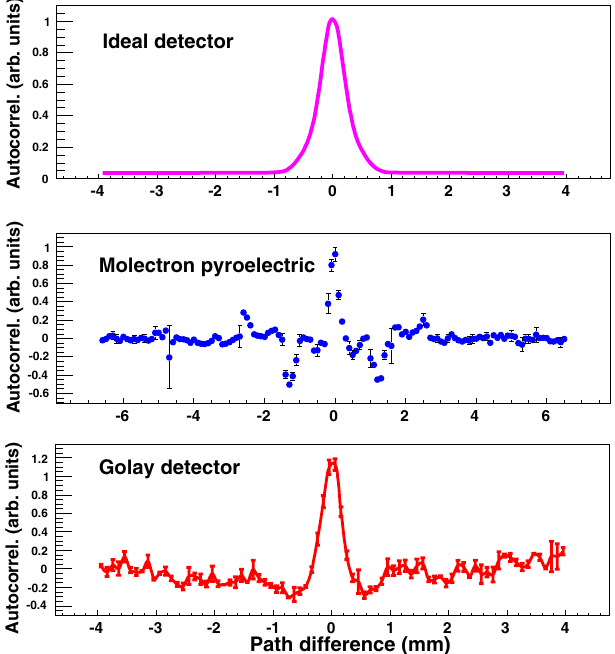
FIG. 4. (Color) Autocorrelation functions for ideal (top), pyro- electric (middle), and Golay (bottom) detectors. Experimental autocorrelation function for Molectron pyroelectric detectors is the same as the one displayed in Fig.